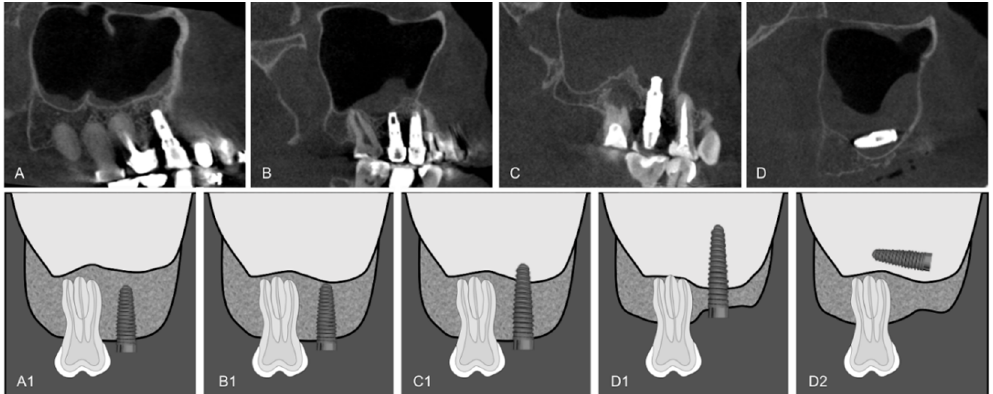
Figure 1. Dental implants in relation to the maxillary sinus: ( A , A1 ) Up to 2 mm from the maxillary sinus cortex; ( B , B1 ) Within 2 mm to intimate contact with the maxillary sinus cortex; ( C , C1 ) Apical third inside the maxillary sinus; ( D , D1 ) Two-thirds inside the maxillary sinus; ( D , D2 ) Totally inside the maxillary sinus.